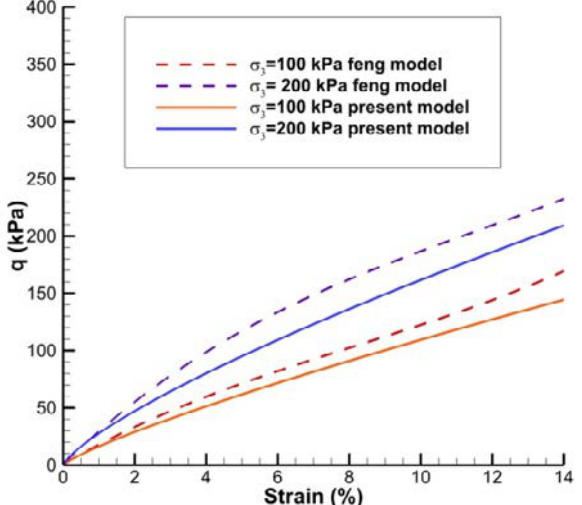
Fig. 6: Comparison of the presented model and Feng’s model at confining stresses of 100 and 200 kPa